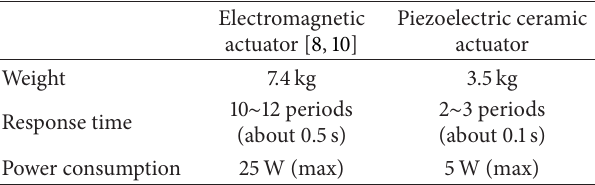
Table 2: Comparison of two